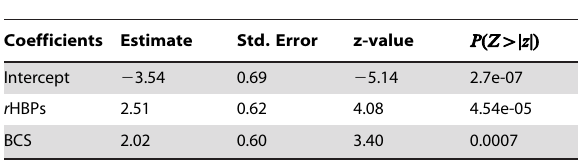
Table 2. Fitted model of the logistic regression analysis of the pregnancy rates for estimating the percentages of gestations under the different experimental